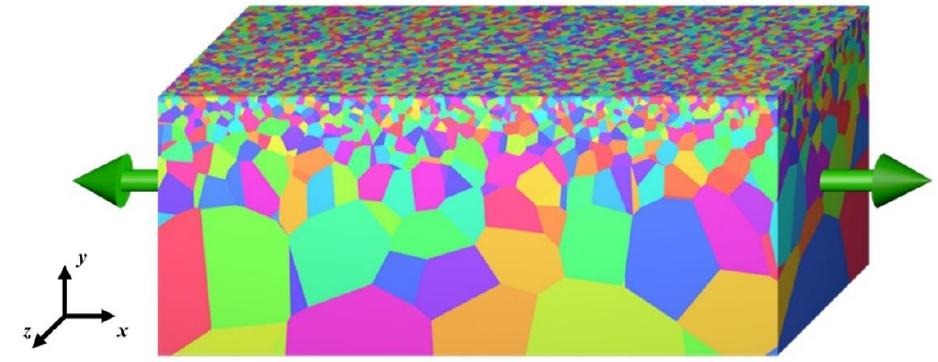
Figure 1. Schematic of a computational model for gradient nano-grained Cu.